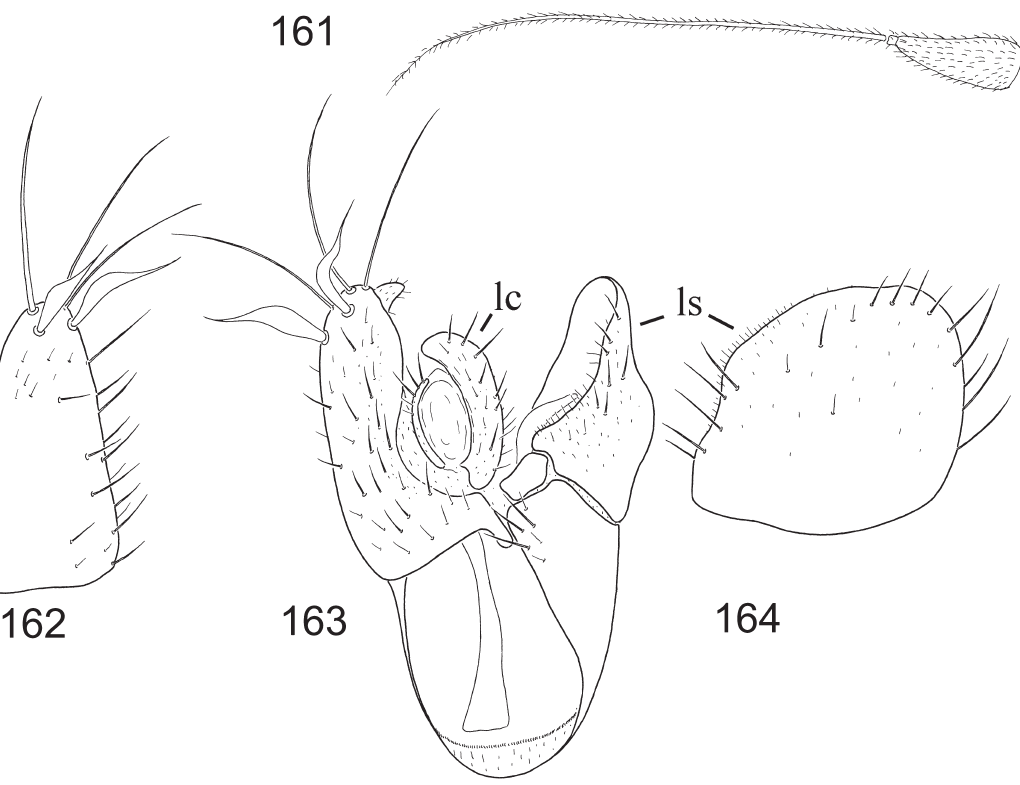
Figs 161-164. Elaphropeza collini sp. nov., ♂. 161 . postpedicel and stylus of antenna, lateral view. 162 . right epandrial lamella, lateral view. 163 . epandrium with cerci, dorsal view. 164 . left surstylus, lateral